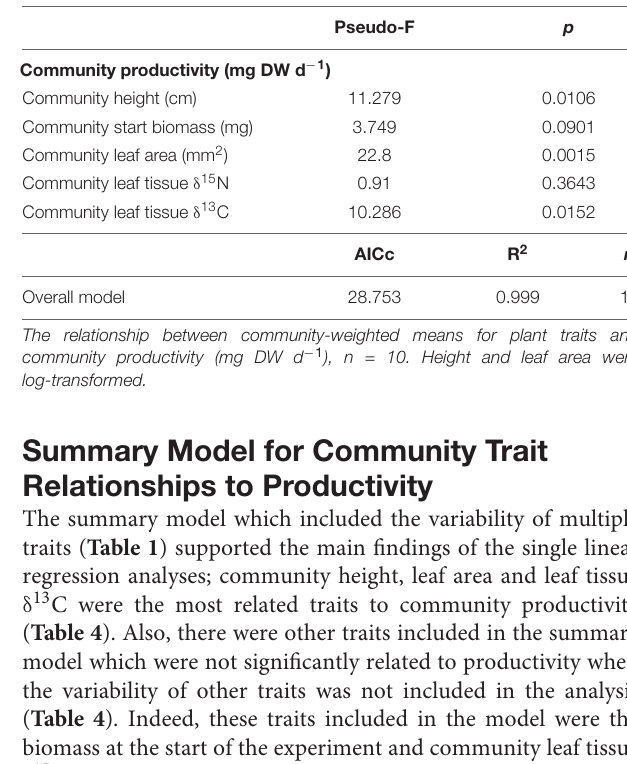
TABLE 4 | Permutation-based multiple regression